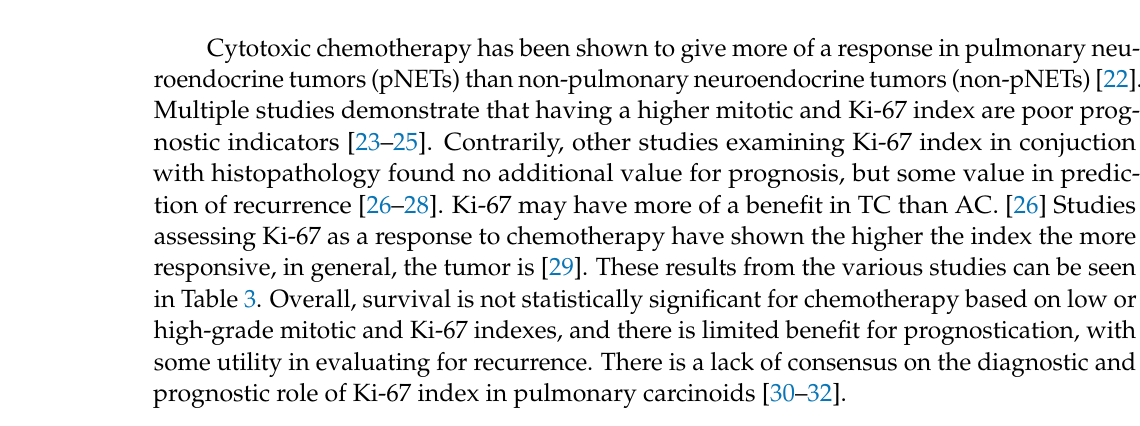
Table 3. Summary of Ki-67 indices in pulmonary and non-pulmonary carcinoids from selected studies. Boland